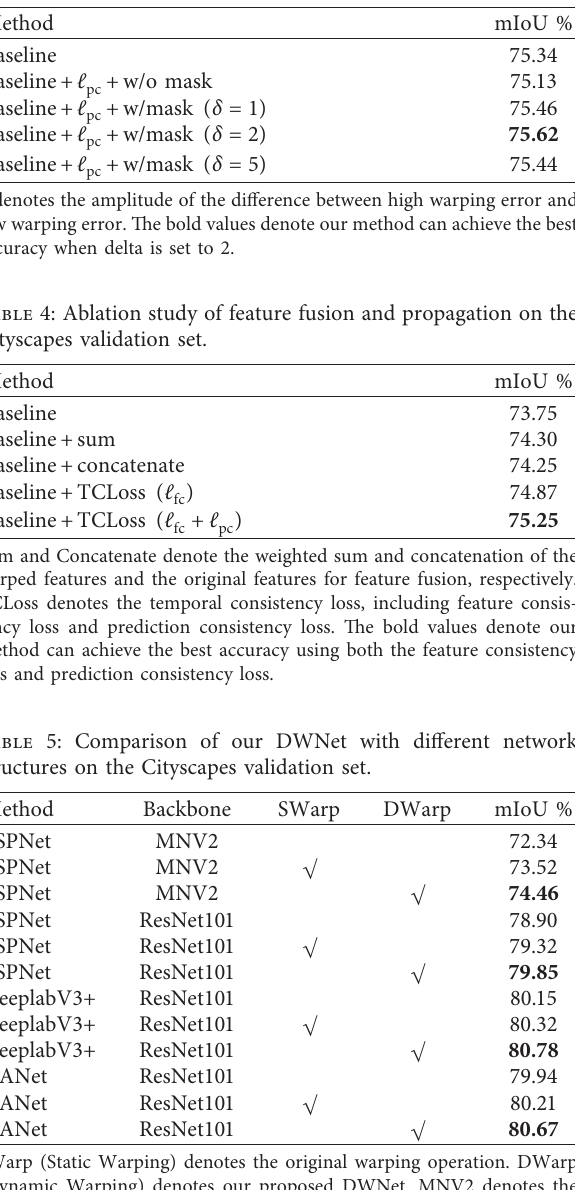
Table 2: Ablation study of the flow-guided convolution on the Cityscapes validation set.